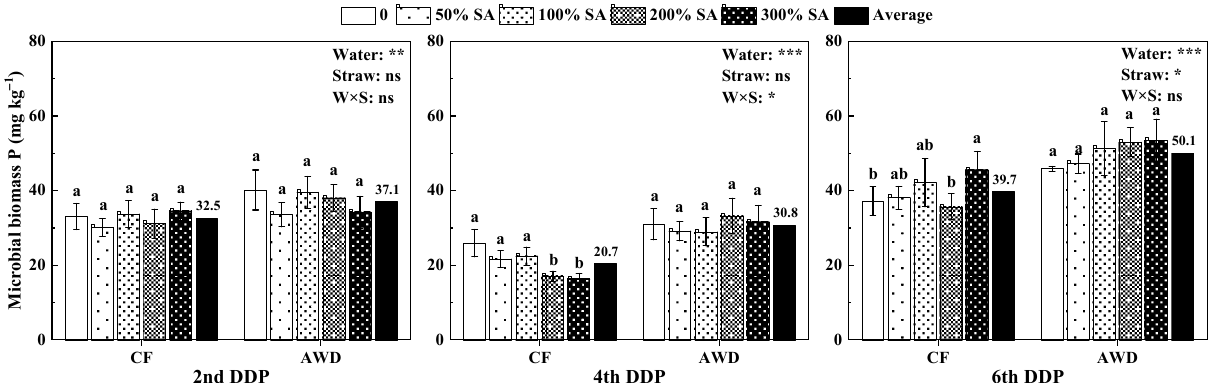
Figure 4. Soil microbial biomass P content under different water management regimes and straw addition rates. Different letters indicate significantly different at p < 0.05 under the same water management regime. Data in the figures indicate means of three replicates ± standard deviation. * means p < 0.05; ** means p < 0.01; *** means p < 0.001; ns means non ‐ significant. CF, continuous flooding irrigation; AWD, alternate wetting and drying irrigation; SA, straw addition rate. DDP, day of the drying period.